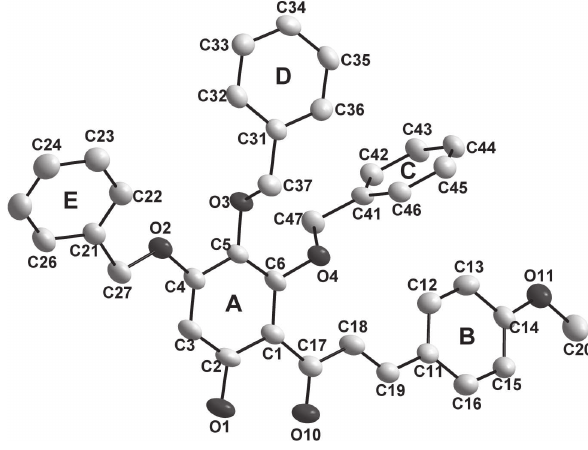
Table 1: Data collection and handling.